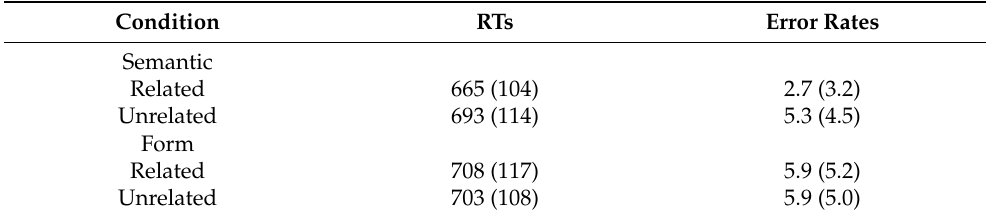
Table 5. Mean reaction times (ms) and error rates (%) in the four experimental conditions (standard deviations in